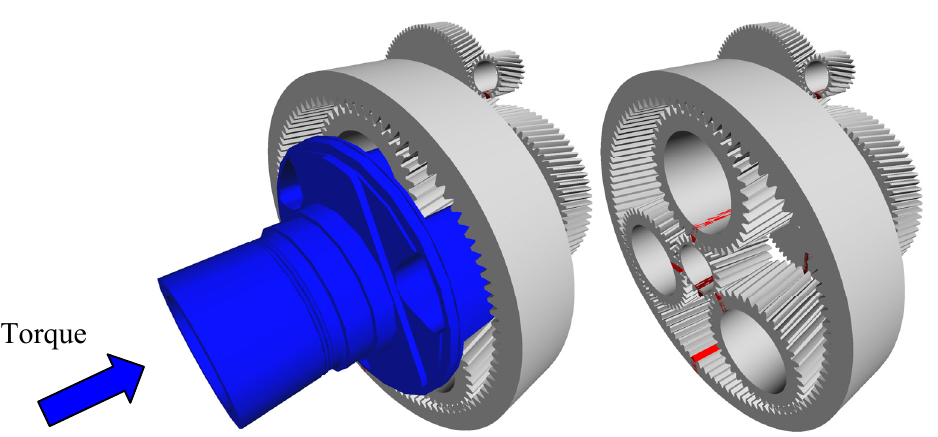
Figure 4. Gearbox model primitive in SIMPACK.